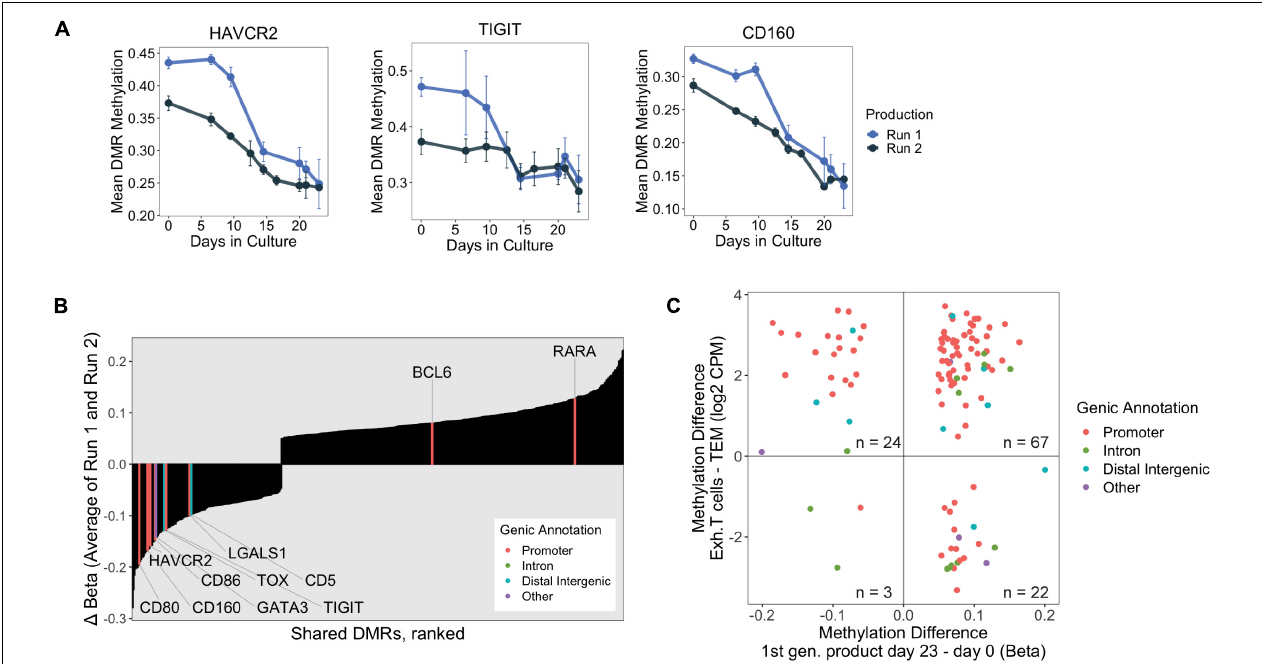
FIGURE 4 | (A) DNA methylation changes over 23 days at the promoters of select exhaustion-associated loci. (B) Consistently “Late” shared DMRs were ranked by final change in methylation (Day 23 – Day 0, averaged over both production runs). Genes implicated in exhaustion, taken from publicly available datasets, are highlighted with associated genic annotation. Notably, many of the exhaustion associated genes are among the strongest hypomethylated DMRs. (C) Scatter plot displaying shared DMRs which overlapped with ExhDMRs identified from WGBS comparing exhausted CD8 T cells vs. CD8 effector memory T cells. The x-axis depicts methylation difference between day 23 and day 0 products (average of both runs), and y-axis depicts methylation difference between functionally exhausted CD8 T cells (Exh. T cells) and CD8 effector memory T cells